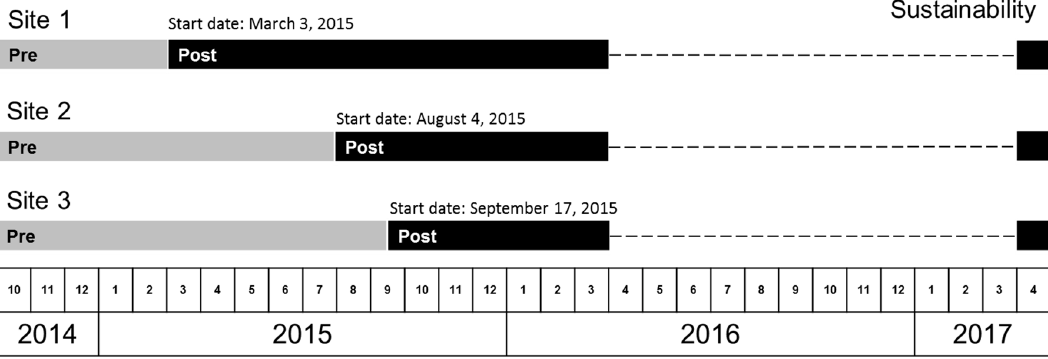
Figure 1. Pre- and post-implementation periods for Sites 1–3.